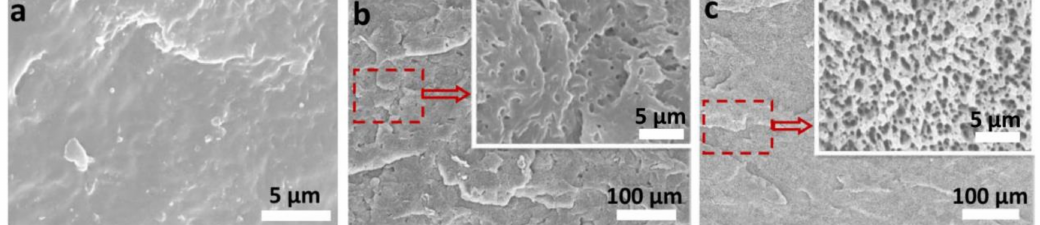
Figure 2. Microstructure of the polypropylene (PP) composites after etching, inset with the partial enlargement: ( a ) pure PP, ( b ) PP/thermoplastic rubber (TPR), ( c ) PP/polyolefin elastomer